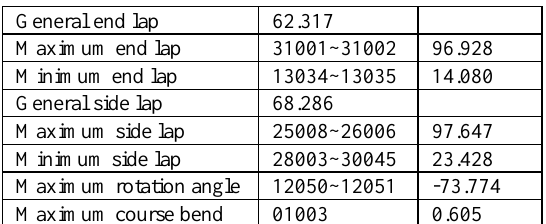
Table 4 . Statistics of flight quality inspection results